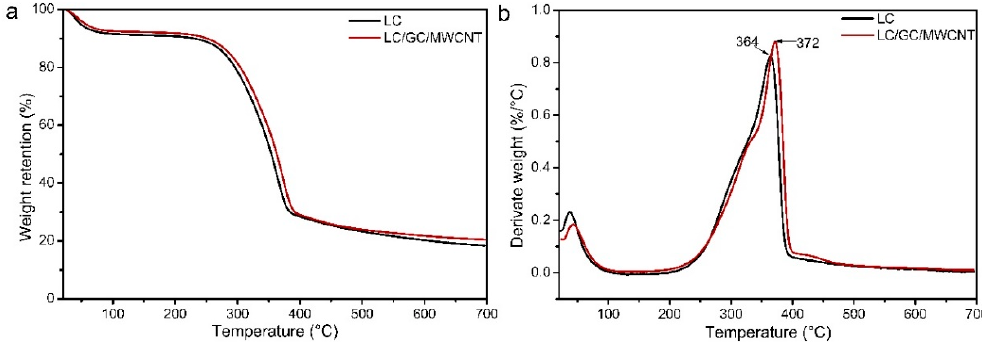
Figure 6. TG-DTG curves of LC composite and LC/GC/MWCNT composite ( a ) TG curves; ( b ) DTG curves.